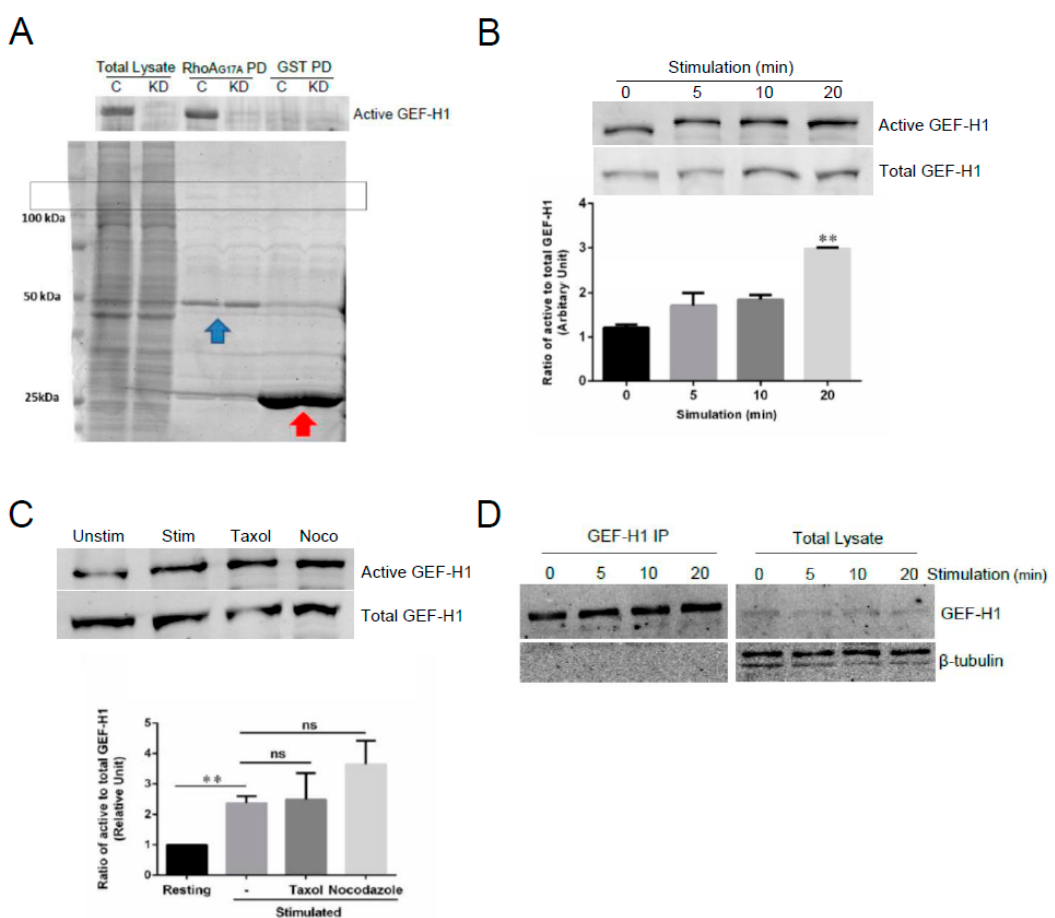
Figure 8. GEF-H1 is activated in RBL-2H3 cells during antigen stimulation. GEF-H1 activation was determined by a pulldown assay using immobilized GST-RhoA-G17A, a nucleotide-free mutant of RhoA that has a high affinity for RhoA-associated active GEFs. ( A ) Detection of active GEF-H1 in RBL-2H3 cell lysates prepared from control ( C ) and GEF-H1-depleted ( KD ) cells. The total lysate is 10% of the sample that was incubated with the GST-RhoAG17A probe, or GST only for the control. Coomassie blue stained gel (lower panel) showing lysates, GST-Rho-G17A (blue arrow), and GST (red arrow) in the pulldown. The box indicates the position of GEF-H1. ( B ) Active GEF-H1 levels increased during antigen stimulation. An immunoblot of active GEF-H1 from a GST-RhoA-G17A pulldown (upper panel) and 10% load control (lower panel) of RBL-2H3 cell lysates prepared after antigen stimulation. Active GEF-H1 levels were quantified by band densitometry of immunoblots and statistically analyzed by one-way ANOVA ( p = 0.0024; n = three independent blots). Tukey’s tests were used to identify significant differences in pairwise comparisons between stimulation times (** p = 0.0018 comparing 0 vs. 20 min stimulation). ( C ) GEF-H1 activation was not affected by microtubule-targeted drugs. An immunoblot of active GEF-H1 (upper panel) and total GEF-H1 from a 10% load control (lower panel) of RBL-2H3 cell lysates antigen-stimulated for 0 min (Unstim) or 20 min (Stim), or stimulated 20 min after pretreatment with 10 µ M of taxol (Taxol) or 10 µ M of nocodazole (Noco). Active GEF-H1 levels were quantified by band densitometry of immunoblots and statistically analyzed by one-way ANOVA ( p = 0.0046; n = three independent blots). Tukey’s tests were used to identify significant differences in pairwise comparisons between stimulation conditions (** p = 0.0018 comparing 0 vs. 20 min stimulation; ns, not significant comparing GEF-H1 activation levels in stimulated cells vs. pretreatment with taxol or nocodazole). ( D ) Tubulin was not detected in GEF-H1 immunoprecipitates. RBL-2H3 cells were stimulated for 0–20 min, lysed, and GEF-H1 was immunoprecipitated using a GEF-H1-specific antibody. Immunoblots show no β -tubulin in GEF-H1 IP